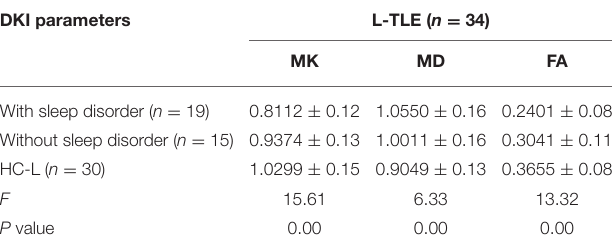
TABLE 3 | ANOVA of DKI parameters between L-TLE with or without sleep disorders and the healthy controls. DKI parameters L-TLE ( n =